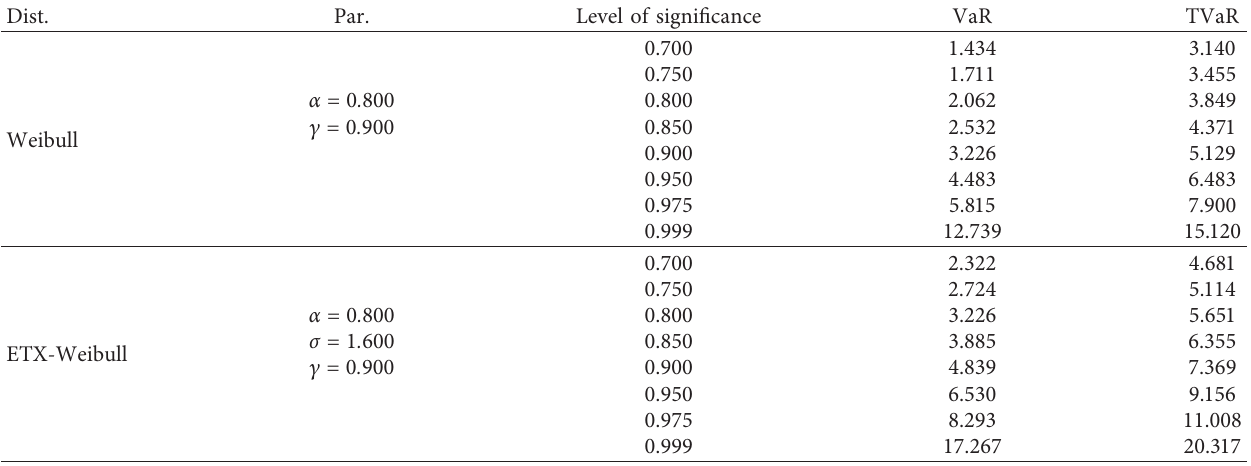
Table 1: Simulation results of VaR and TVaR of the Weibull and ETX-Weibull distributions for n � 150. Dist.